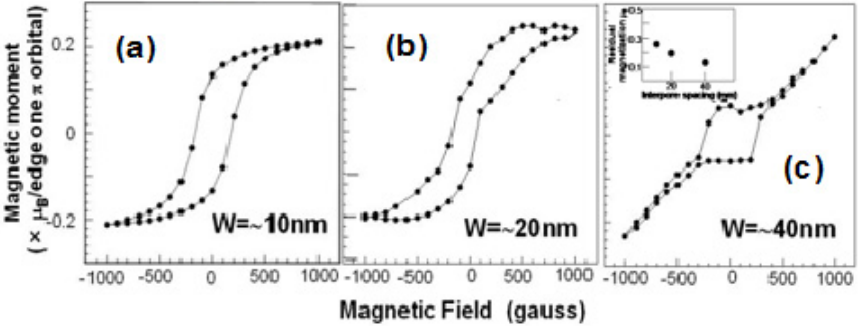
× 2) is ~0.28 μ , ~0.2 μ , ~0.12 μ and r B B B × 2) is ~400 gauss, ~260 gauss, c at 300 K as a function of W r